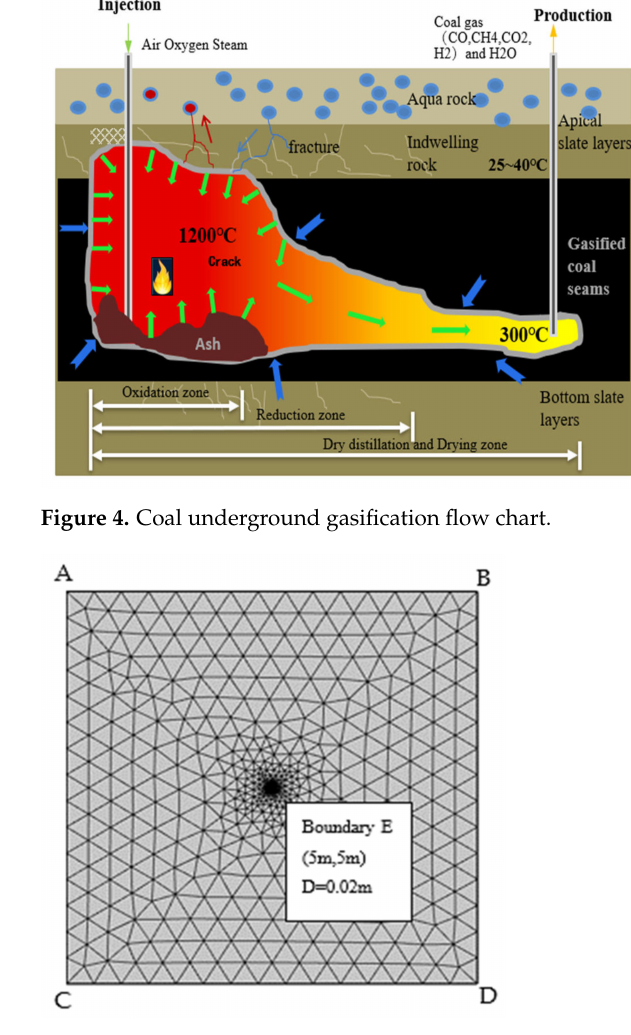
Figure 5. Coal seam mesh